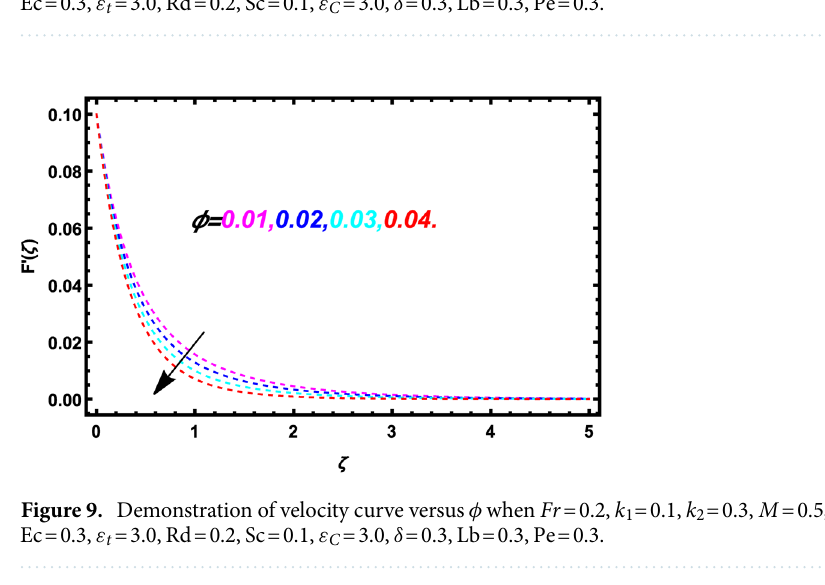
Figure 8. Demonstration of velocity curve versus m when Fr = 0.2, k 1 = 0.1, k 2 = 0.3, M = 0.5, Pr = 5.3, φ = 0.01, Ec = 0.3, ε Rd = 0.2, Sc = 0.1, ε Lb = 0.3, Pe = 0.3. t = 3.0, C = 3.0, δ = 0.3,